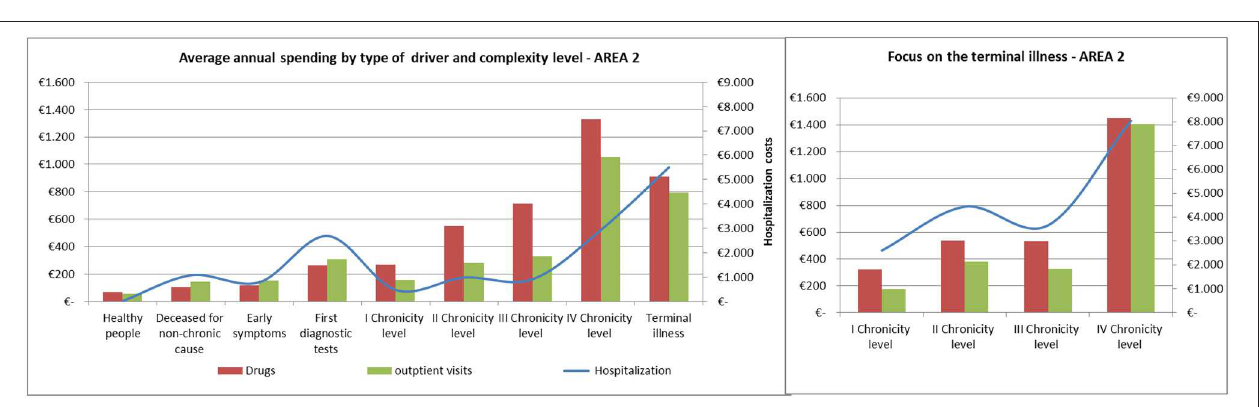
FIGURE 9 | Complexity progression over